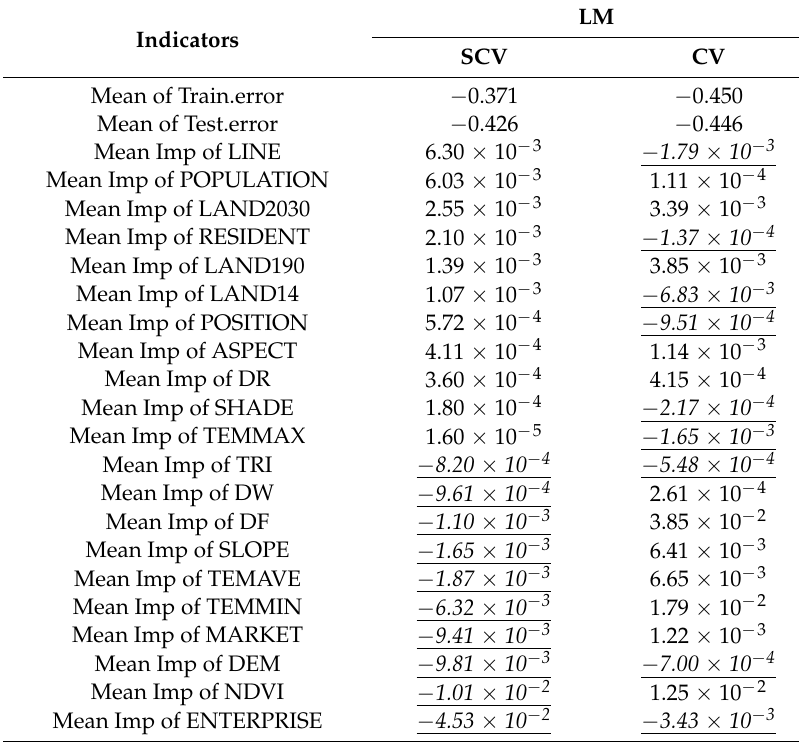
Table 3. Results of SCV and CV for linear regression.